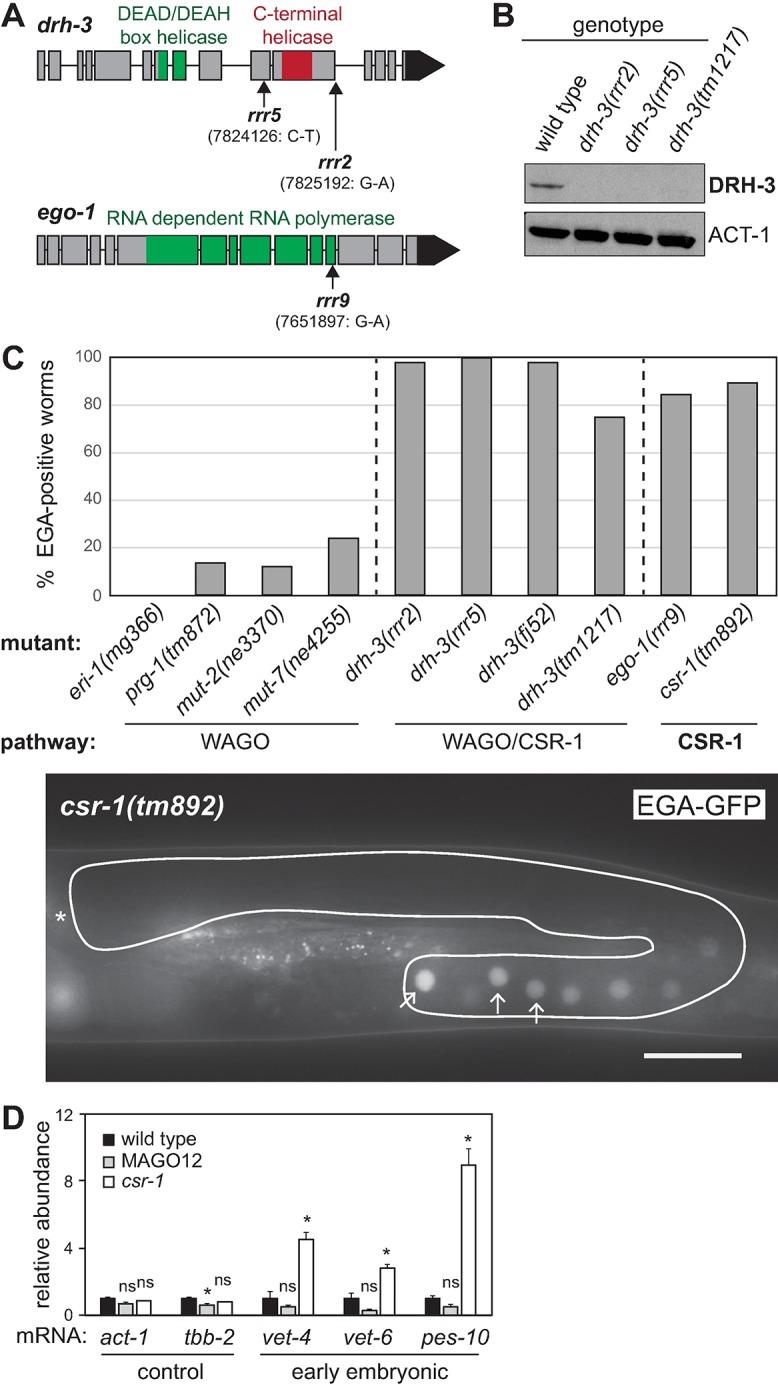
EGA repression in the germline is mediated via the CSR-1 pathway.(A) Schematic view of the drh-3 and ego-1 genes with highlighted known protein domains. Arrows indicate the locations of the identified mutations. The drh-3(rrr2) mutation affects a splice donor residue, likely leading to a splicing defect. The drh-3(rrr5) mutation, located in exon 10, is causing a precocious stop codon (Q647>Stop). The ego-1(rrr9) mutation is located in exon 12, and leads to a nonsynonymous amino acid change (A1271>V). Genomic locations according to C. elegans May 2008 (WS190/ce6) assembly. (B) Western blot analysis of lysates from wild type or drh-3 mutants, probed for DRH-3 and ACT-1 (as a loading control). No DRH-3 protein was detected in the lysates from drh-3(rrr2) and drh-3(rrr5) animals. The drh-3(tm1217) mutation, which was used as a control, is a putative null (containing a 482 bp deletion). (C) Top: Examination of EGA-GFP in mutants affecting various small RNA pathways. Each bar represents the percentage of animals expressing the reporter in germ cells. N>30. Bottom: Fluorescent micrograph from a live csr-1(tm892) animal, grown at 25°C, expressing the EGA-GFP abnormally in the developing oocytes (arrows point to three representative oocytes). Scale bar: 40 μm. (D) Changes of the indicated transcripts in gonads dissected from wild type, a strain containing mutations in all 12 WAGOs (MAGO12), and csr-1(tm892) mutants, by RT-qPCR. Each bar represents the mean of three independent biological replicates. Error bars represent the SEM. The significance of the differences has been calculated with the Student’s t-test: “*”, p<0.05; “n.s.”, not significant.